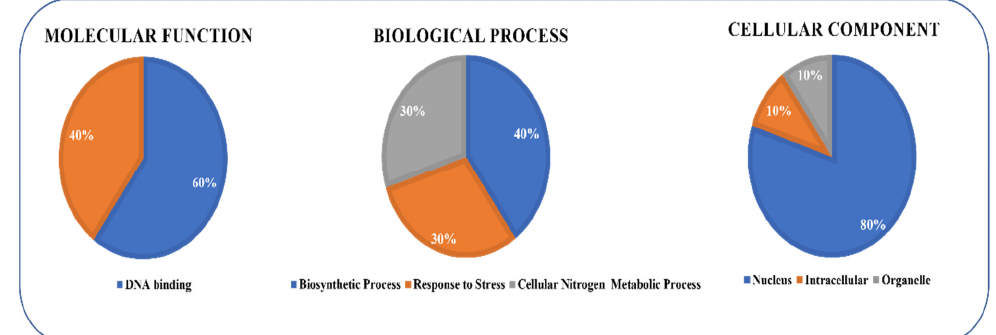
Figure 5. Gene Ontology (GO) enrichment analysis of the GmRWP ‐ RK genes in soybean. The GO enrichment analysis was represented as three different categories including biological processes (BP), molecular (MF) function, and cellular component (CC).